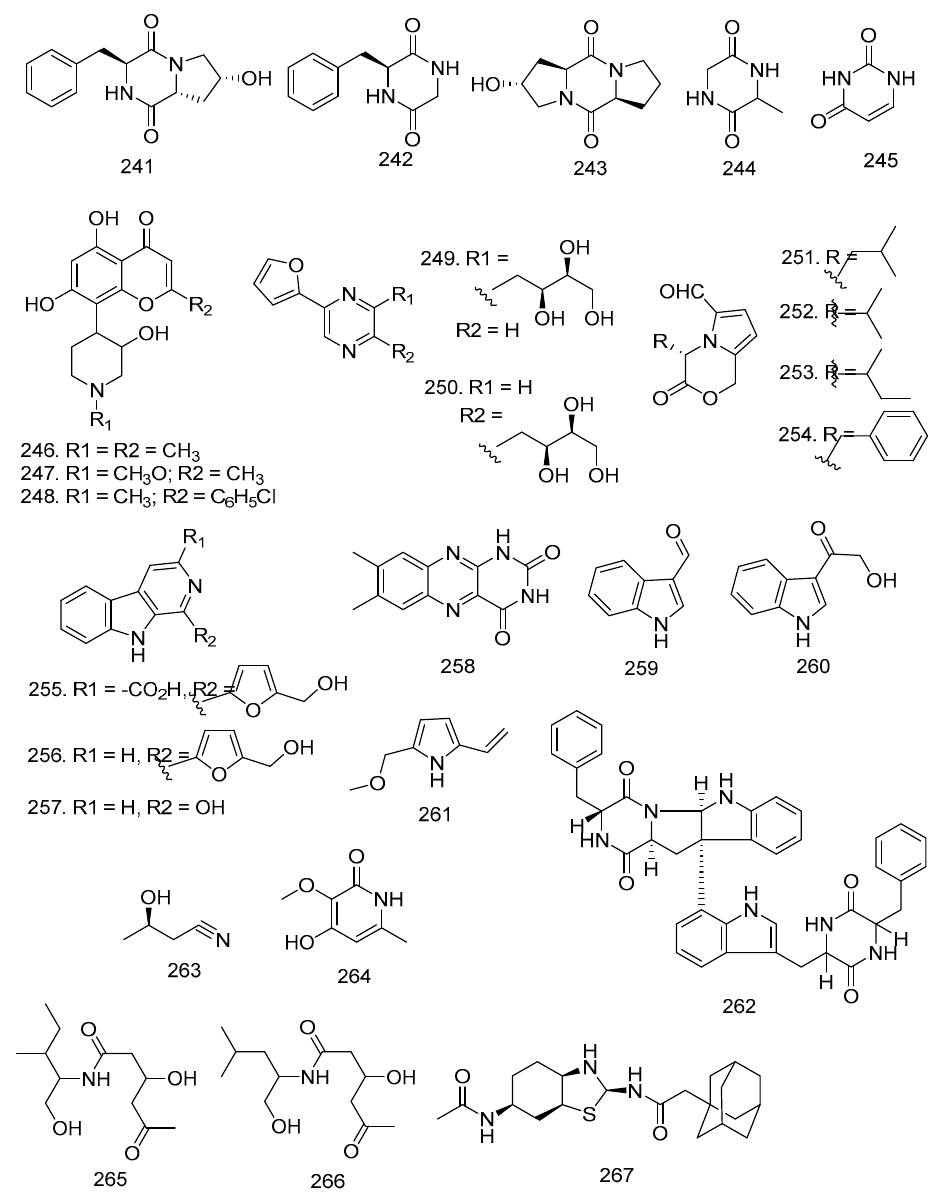
Figure 11. Alkaloids obtained from endophytic fungi in Meliaceae.